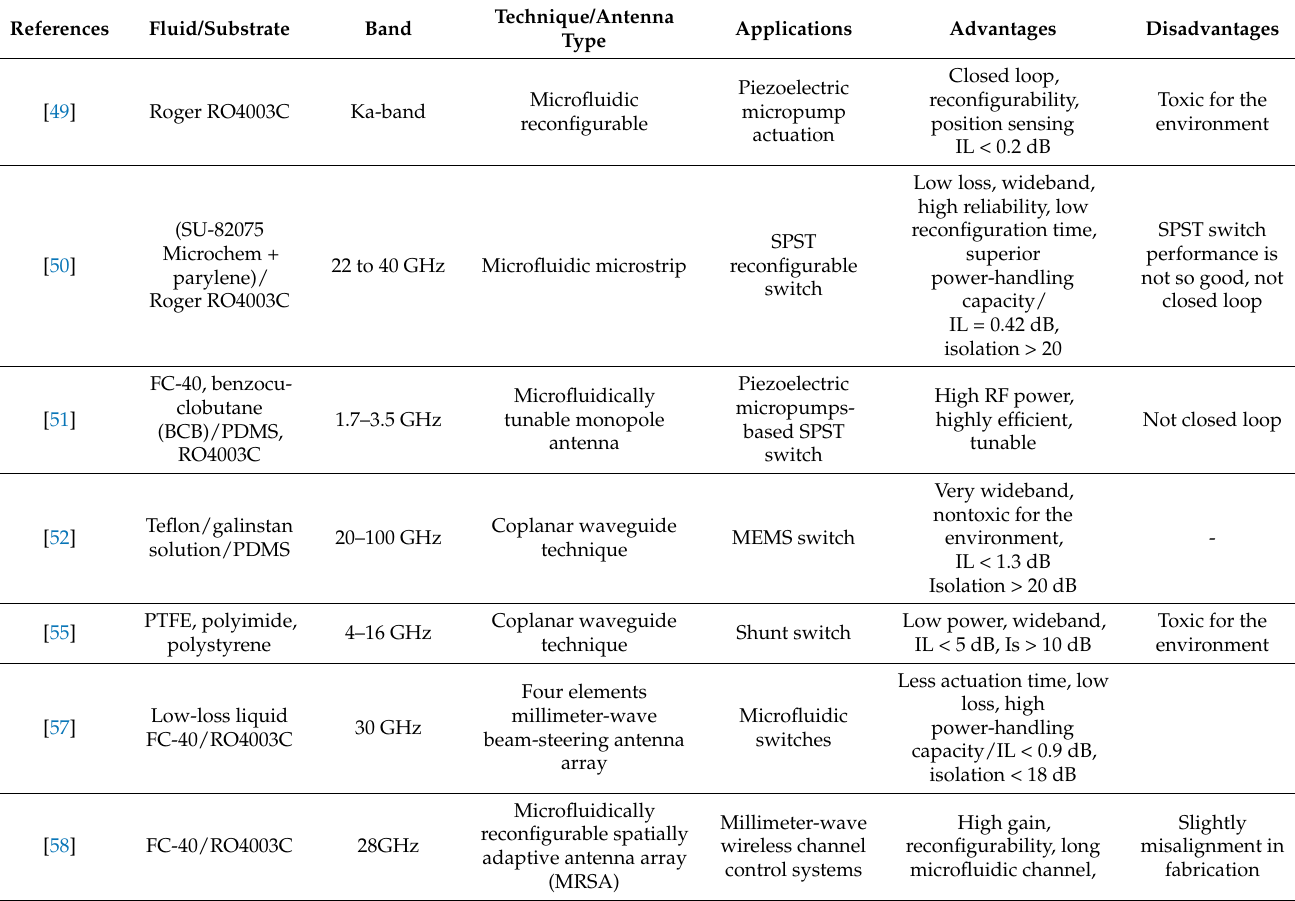
Table 4. Comparison analysis of fluidic based spst